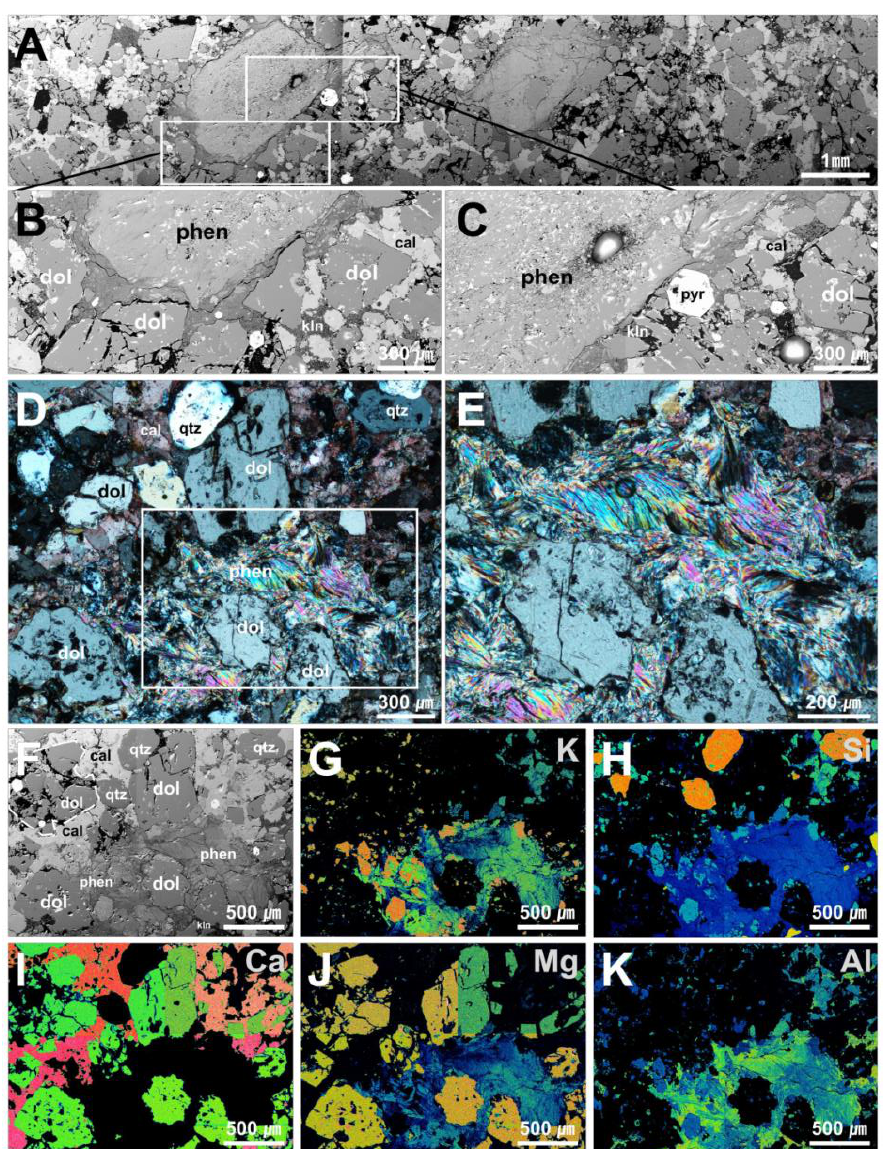
Figure 4. ( A – C ) SEM-BSE image of pore-filling phengites (Type 2) among the crystalline dolomite grains and polycrystalline phengite (Type 1) in carbonate rock, which is followed by calcite filling; ( D , E ) XPL images of typical pore-filling phengites (Type 2); ( F ) SEM-BSE image of Type 2 phengite for element-mapping and the element-mapping results of the BSE imaging part for ( G ) K, ( H ) Si, ( I ) Ca, ( J ) Mg, and ( K ) Al. Abbreviations: qtz—quartz; cal—calcite; dol—dolomite; phen—phengite; pyr—pyrite; kln—kaolinite.